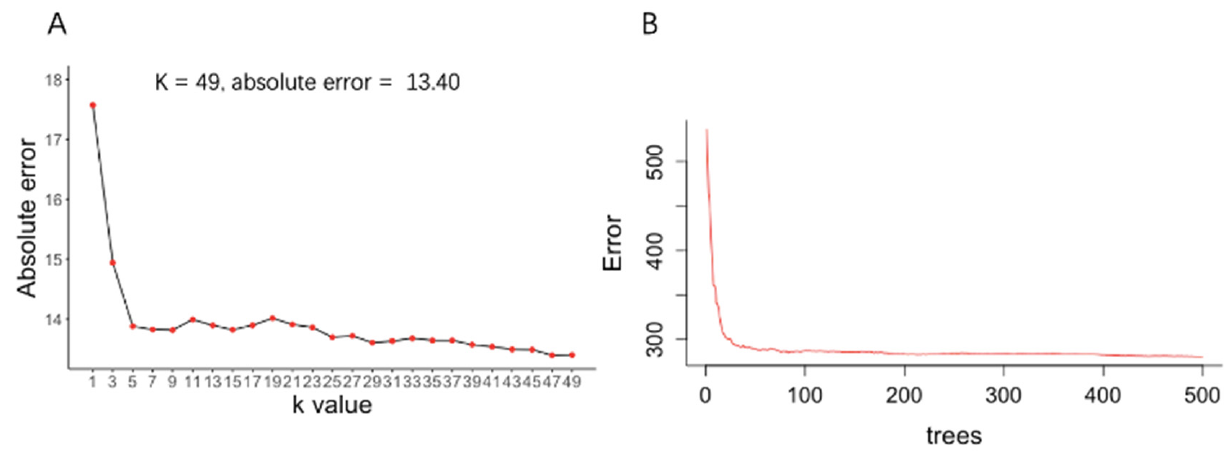
Figure 2. Development of KNN Model and Random Forest Model. ( A ) Development of KNN model; ( B ) Development of Random Forest model.